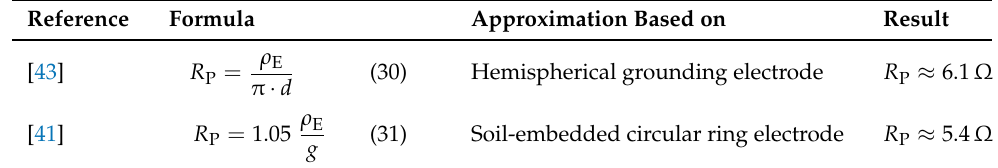
Table 8. Comparison of two different methods to approximate R P of a foundation grounding device.